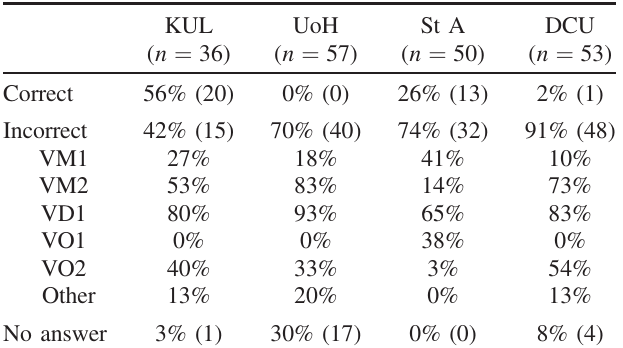
TABLE II. Summary of responses to question 1(a) [Fig. 1(a)]. Incorrect responses are associated with the errors listed in Table I. Since students can exhibit multiple difficulties in a single sketch, the percentages do not sum to